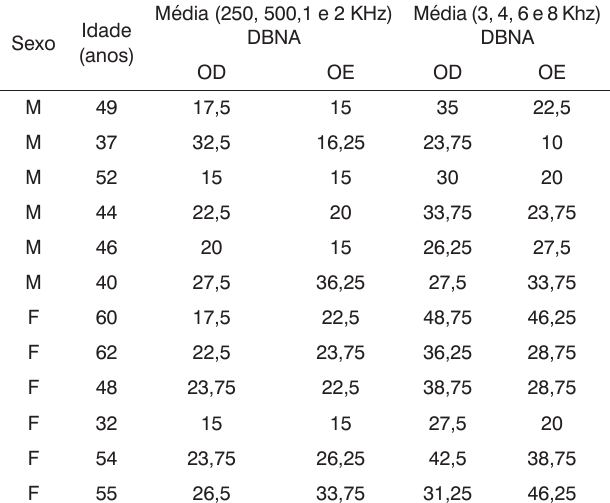
Tabela 1. Médias dos tons puros em baixas e altas frequên - cias nos pacientes com DASN (Grupo A) nas orelhas direitas e esquerdas.